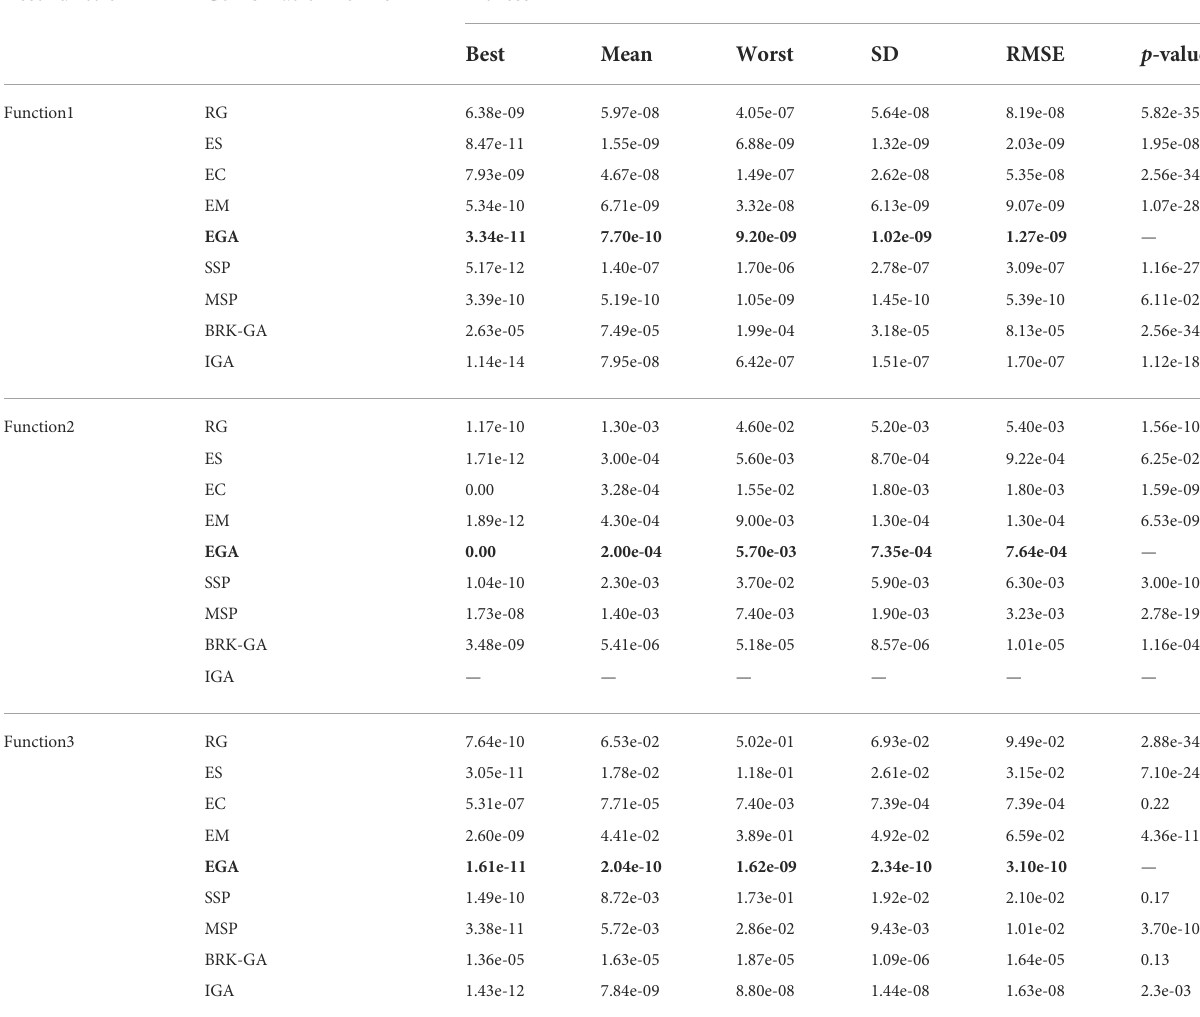
TABLE 3 Results of global indices for each evolutionary process of design experiments